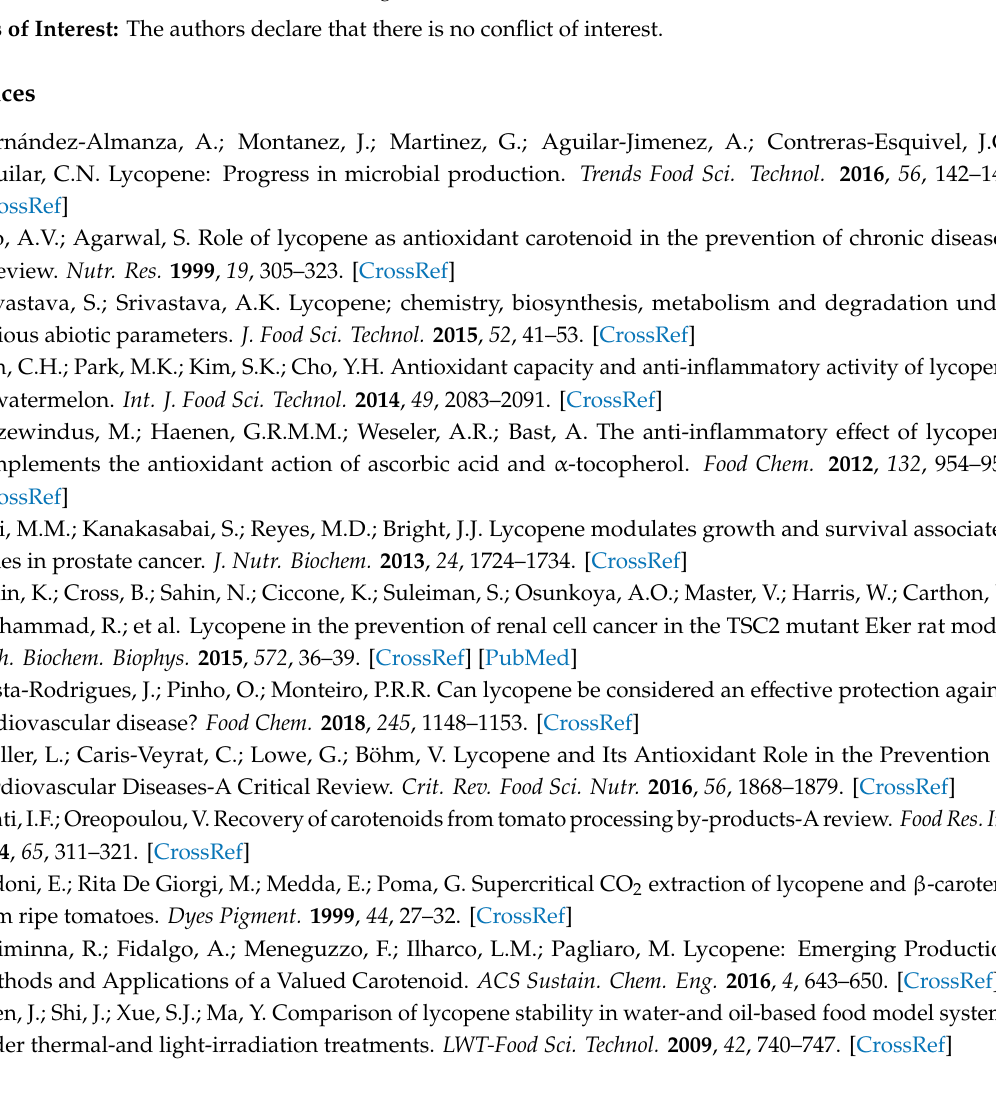
Figure S1: HPLC of lycopene (a), β -CD (b) and inclusion complexes (c) (Detection wavelength: 474nm); β -CD (d) and inclusion complexes (e) (Detection wavelength: 285nm), Figure S2: DSC thermograms of lycopene (a), β -CD (b), their physical mixtures (c) and inclusion complexes